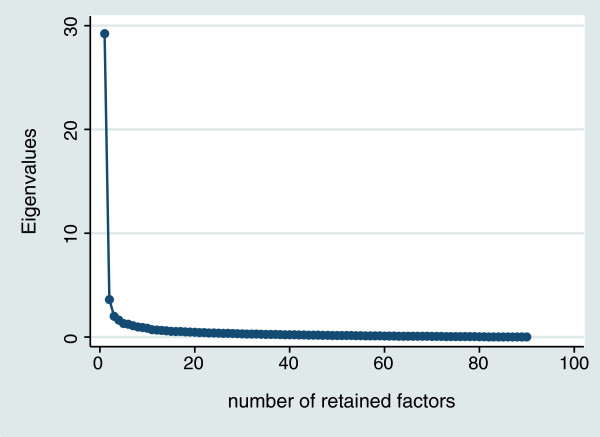
Scree plot of SCL-90-R exploratory factor analysis using iterated principal factor analysis with varimax rotation.